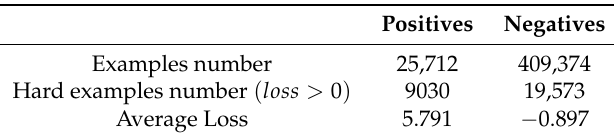
Table 2. The statistics of examples on training